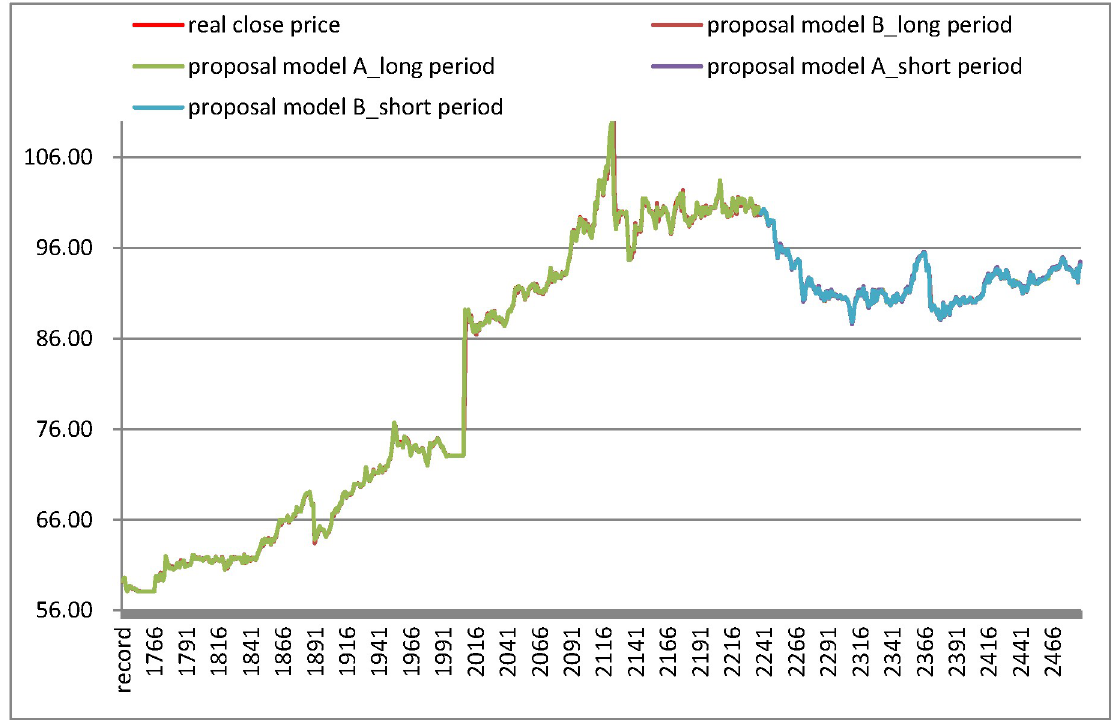
Fig 2. Results of forecasting short and long test period for Chunghwa Telecom datasets.